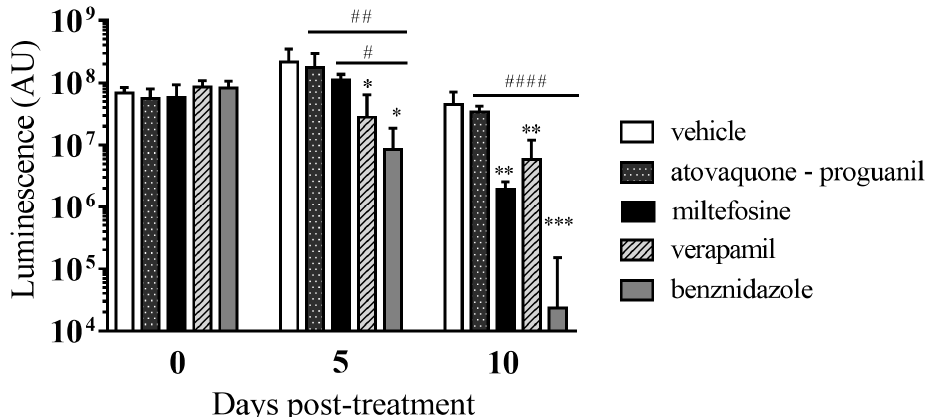
Figure 8. In vivo T. cruzi parasitemia (total flux) at baseline (day 0), and after 5 and 10 days of treatment. Statistically significant differences between drug-treated groups versus vehicle group or BNZ-treated group are respectively indicated by * or # symbols. One symbol indicates p < 0.05, two indicate p < 0.01, three indicate p < 0.001, and four symbols indicate p < 0.0001.